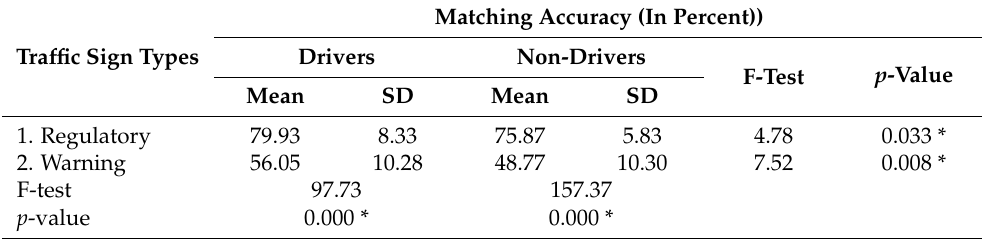
Table 5. Matching accuracy of drivers and nondrivers vs. traffic sign types.